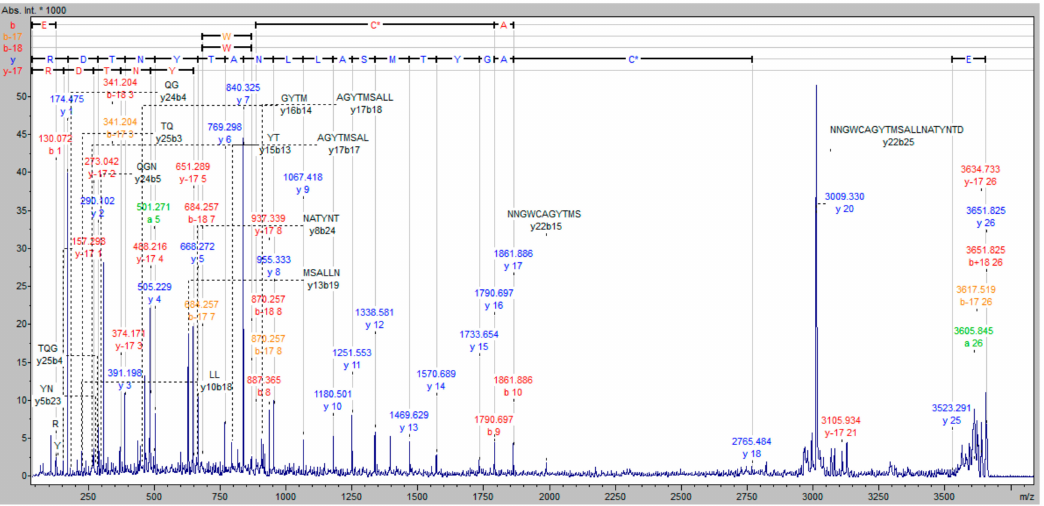
Figure 7. MALDI-TOF / TOF mass spectrum of the peptide (ETQGNNGWCAGYTMSALLNATYNTDR) obtained after tryptic digestion of staphopain C and incubated with a biotinylated inhibitor at pH 7.8. The cysteine modified at its side chain by the reaction with the inhibitor is designated